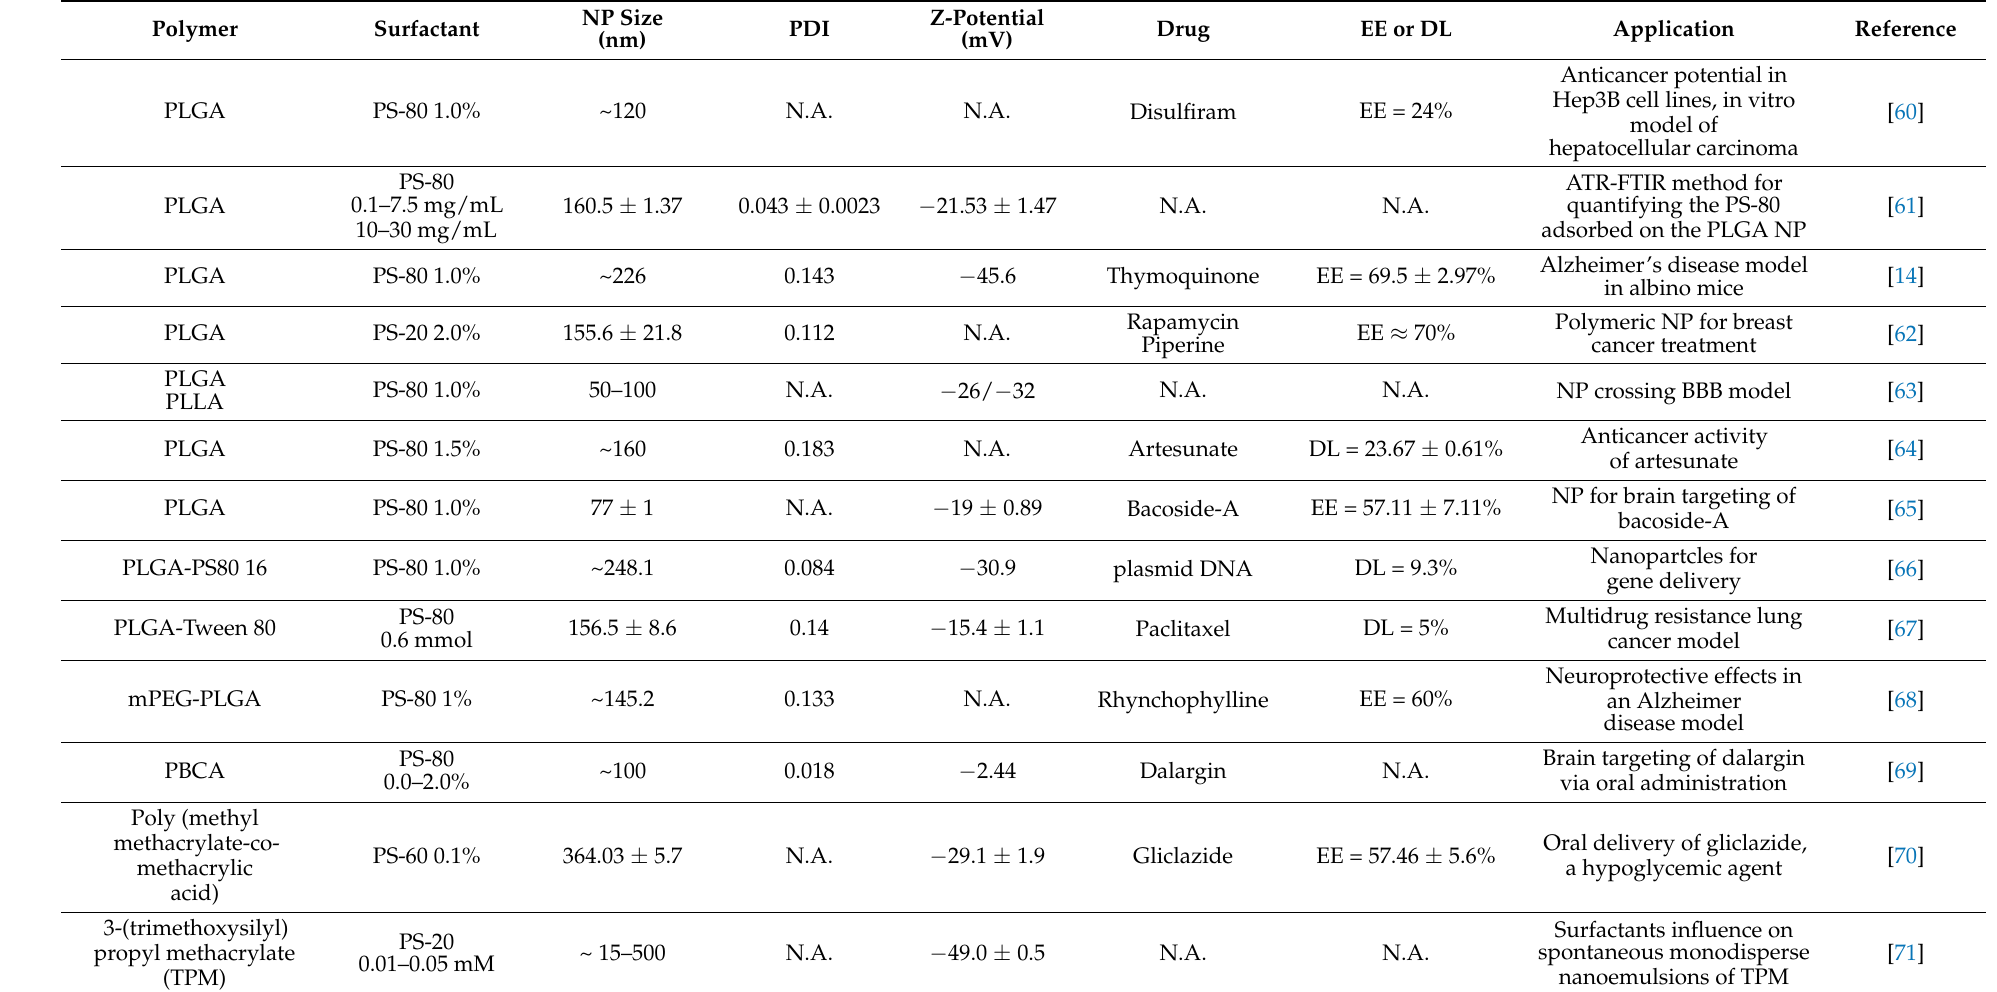
Table 2. Representative polymeric NP stabilized with